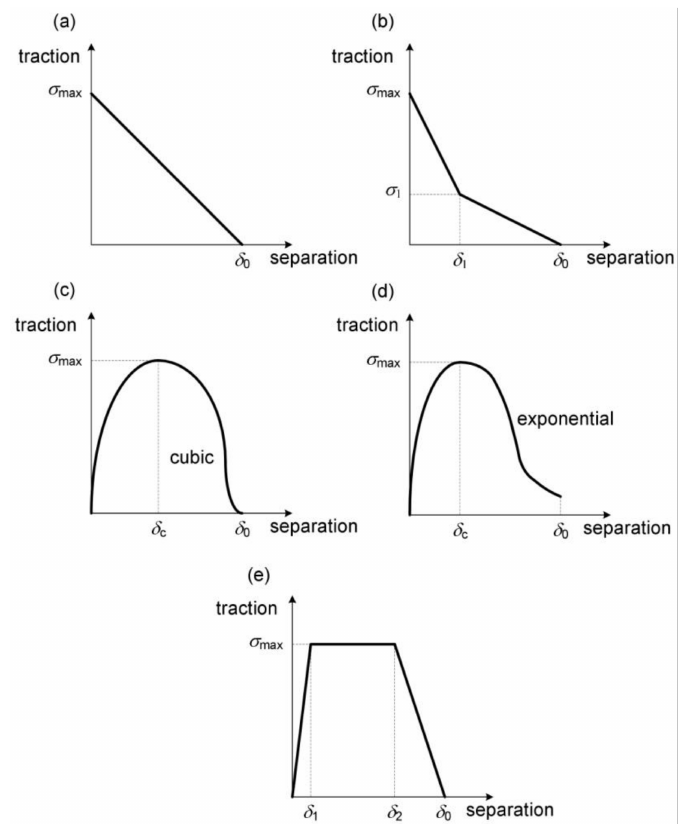
Figure 4. Exemplary traction–separation laws (TSLs) proposed in the literature: ( a ) Hillerborg [8], ( b ) Bažant [9], ( c ) Needleman [10], ( d ) Needleman [11], ( e ) Tvergaard and Hutchinson